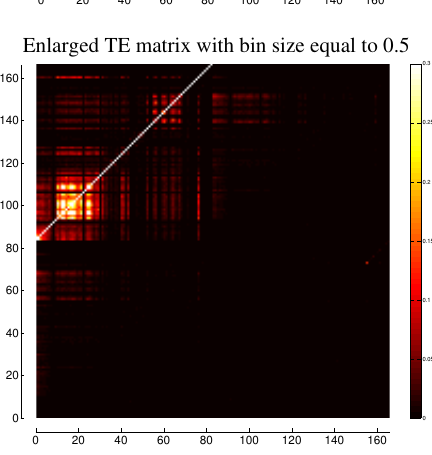
Figure 25. Enlarged TE matrices using three different binning sizes: 0 . 02 , 0 . 1 , and 0 . 5 ,